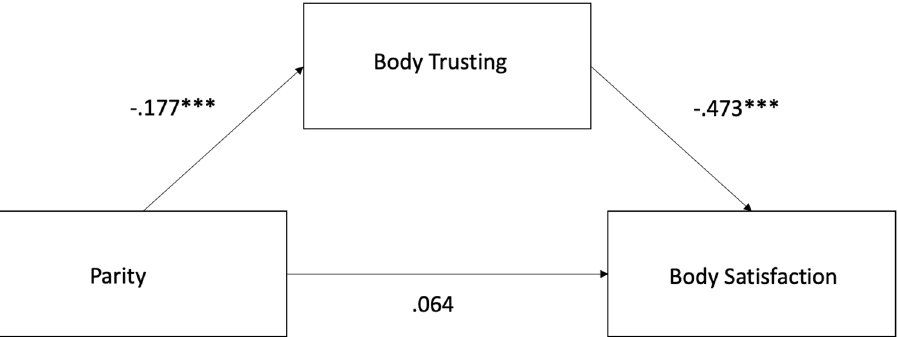
Figure 1. Mediation results for the relationship between parity and pregnancy body satisfaction. Body trusting was found to be a significant mediator, such that differences in body satisfaction between primiparous and multiparous women are mediated by changes in body trust.